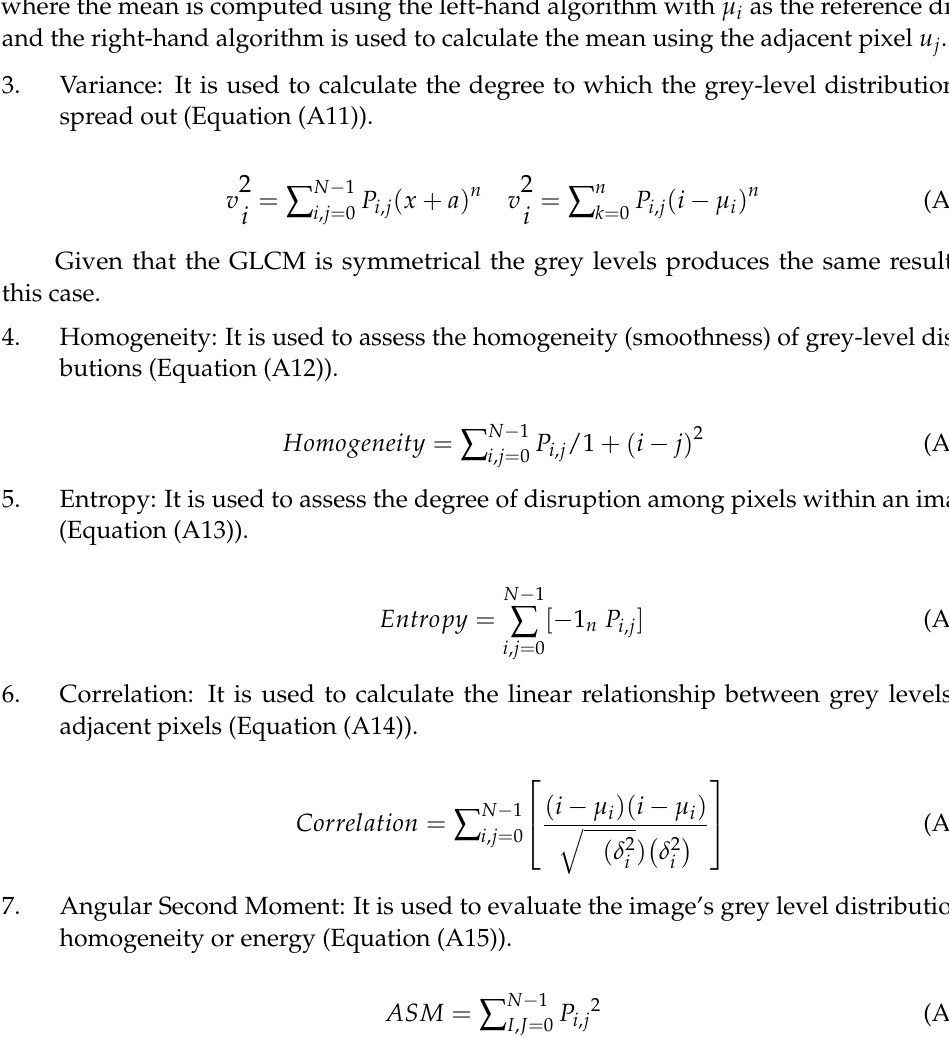
3. Variance: It is used to calculate the degree to which the grey-level distribution is spread out (Equation (A11)).